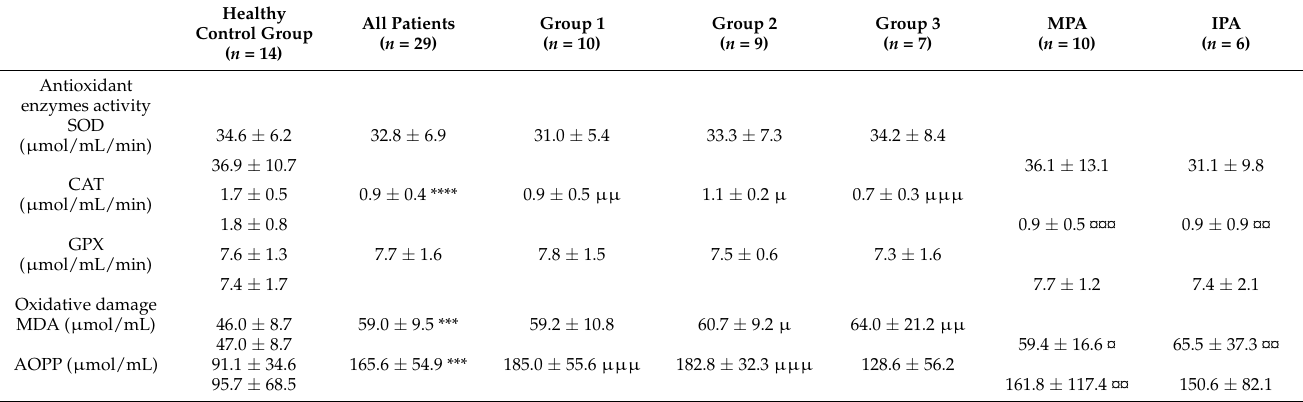
Table 1. Antioxidant enzymes activity and oxidative stress damage in PA level groups (group 1, 2, and 3) and intensity groups (MPA and IPA) in comparison with healthy subjects. Parametric statistical tests are expressed as mean and standard deviation (written in blue), and non-parametric statistical tests are expressed as median and interquartile range (written in black). AOPP: advanced oxidation protein products; CAT: catalase; GPX: glutathione peroxidase; IPA: intense physical activity; MDA: malondialdehyde; MPA: moderate physical activity; SOD: superoxide dismutase. *** p < 0.001 between all patients and control group. **** p < 0.0001 between all patients and control group. µ p < 0.05 between PA level group and control group. µµ p < 0.01 between PA level group and control group. µµµ p < 0.001 between PA level group and control group. ¤ p < 0.05 between PA intensity group and control group. ¤¤ p < 0.01 between PA intensity group and control group. ¤¤¤ p < 0.001 between PA intensity group and control group.